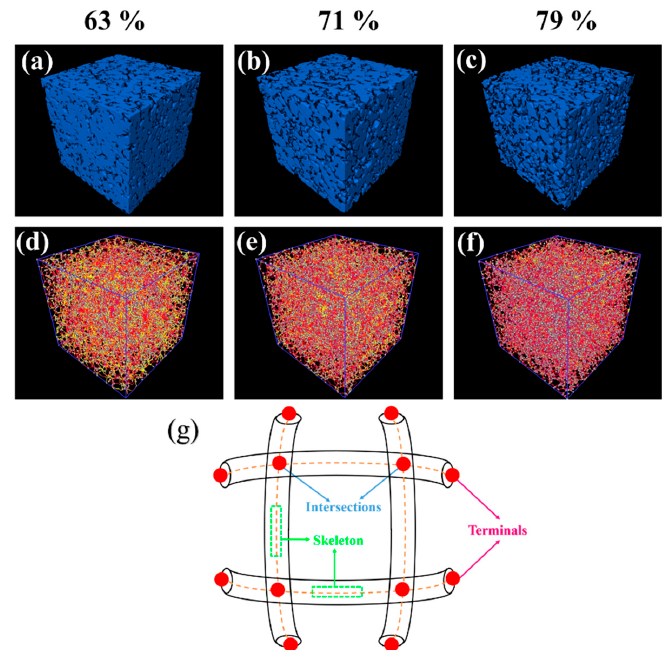
Figure 2. 3D reconstructed images of Ti-10Mo alloys with different content of NH 4 HCO 3 added: ( a , b , c ) matrix and pores; ( d , e , f ) skeletonization image (pore) of samples and ( g ) schematic images of skeletonization.